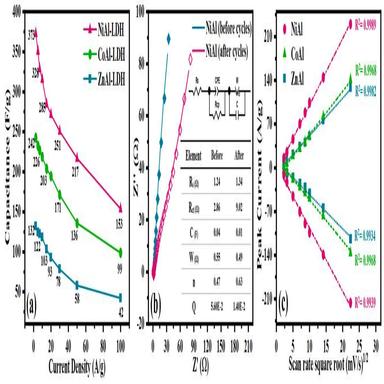
a) Specific charge capacity of electrodes; b) Nyquist plot and the electrical parameters of equivalent circuit (inset) of NiAl-LDH (before and after CV and GCD cycles); c) Randles–Sevcik (square root of the scan rates) graph of electrodes.